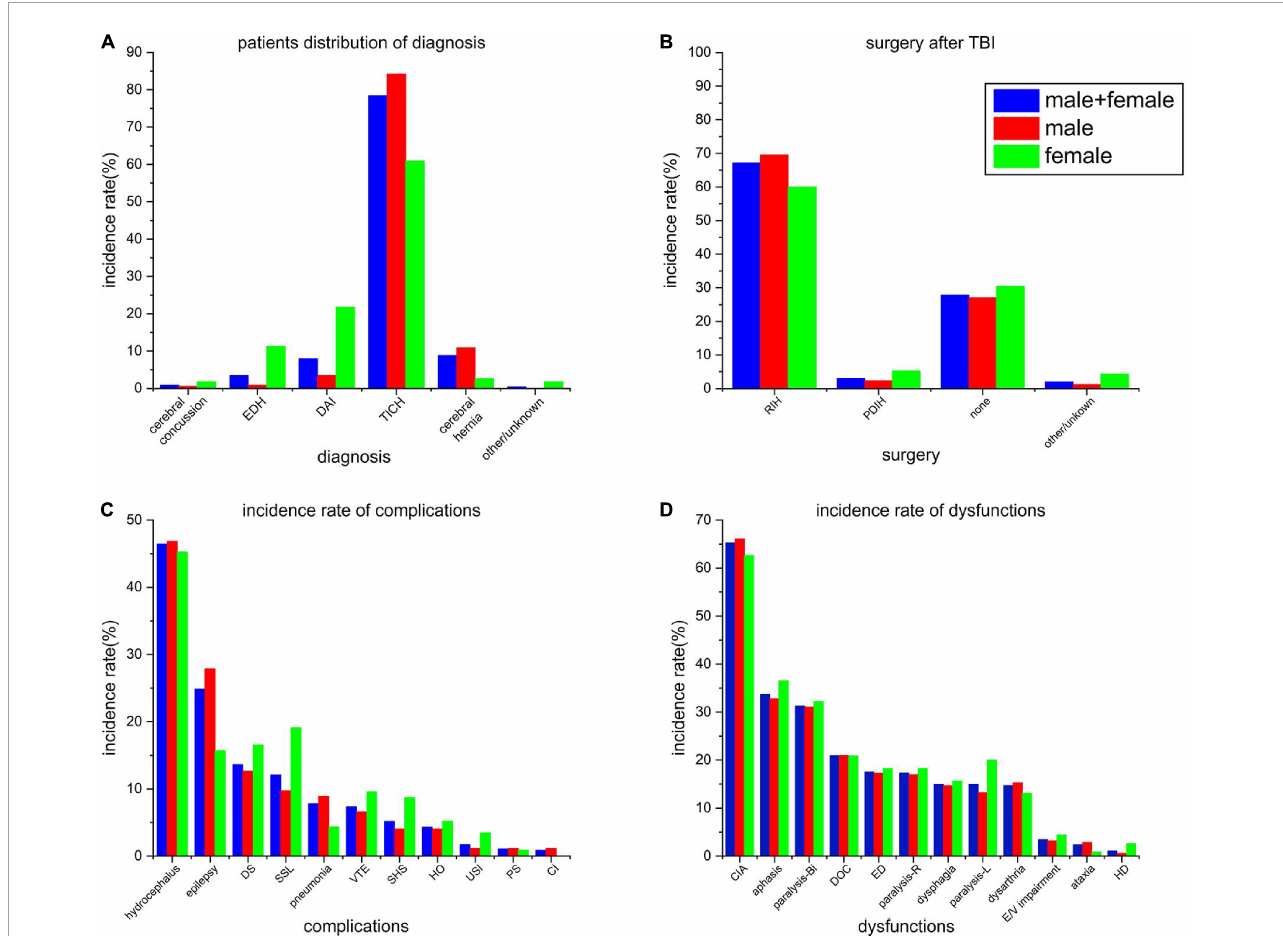
FIGURE3 (A) Patient distribution of incidence rate of principal diagnosis. (B) Rate of the different types of surgeries after TBI. (C) Incidence rates of all the complications at the time of admission. (D) Incidence rate of all the dysfunctions at the time of admission. EDH, epidural hemorrhage; DAI, diffuse axonal injury; TICH, traumatic intracranial hemorrhage; RIH, removal of intracranial hemorrhage; PDIH, puncture drainage of intracranial hemorrhage; DS, disuse syndrome; SSL, shoulder subluxation; VTE, venous thromboembolism; SHS, shoulder-hand syndrome; HO, heterotopic ossification; USI, urinary system infection; PS, pressure sores; CI, secondary cerebral infarction after stroke; CIA, cognitive impairment assessment; DOC, disturbance of consciousness; ED, emotional disorder; E/V impairment, eyesight/vision impairment; and HD, headache or